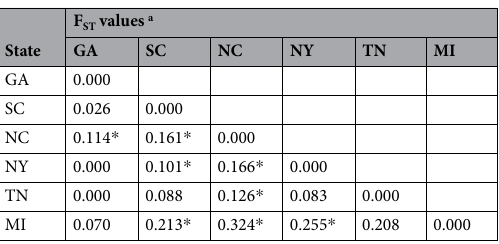
Table 4. Genetic differentiation of populations of Phytophthora capsici from 6 states. a F ST values were calculated in GenALEx 6.5. Values followed by * are significantly different from zero at P < 0.005, using 999 permutation.